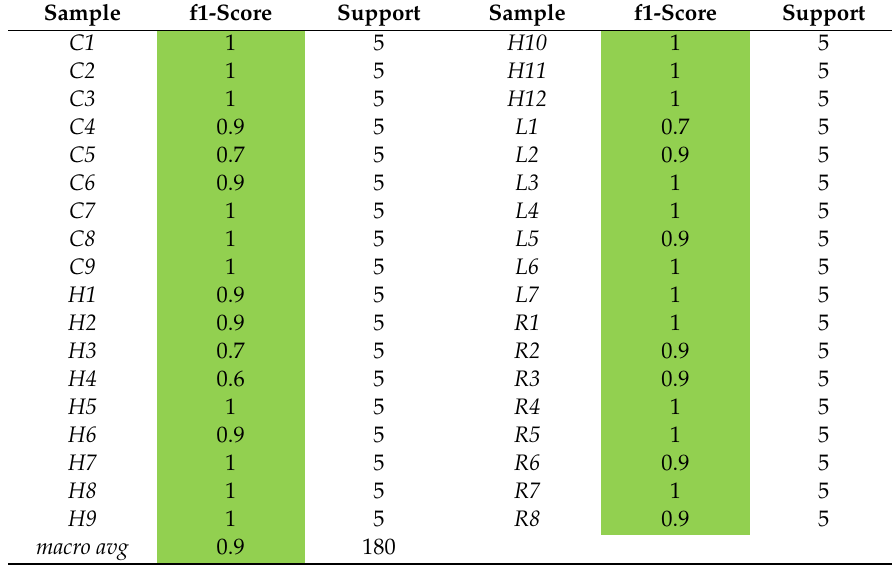
Table 3. Classification report for PCA-preprocessed LDA prediction model, used to predict new LIBS spectra from all